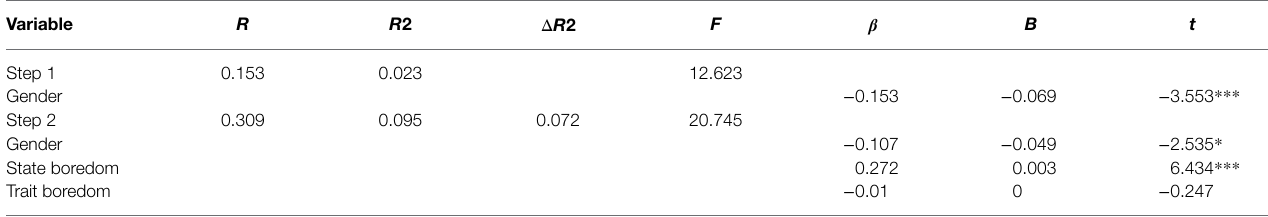
TABLE 4 | Hierarchical multiple regression analysis of gender, state and trait boredom as predictors of FR.